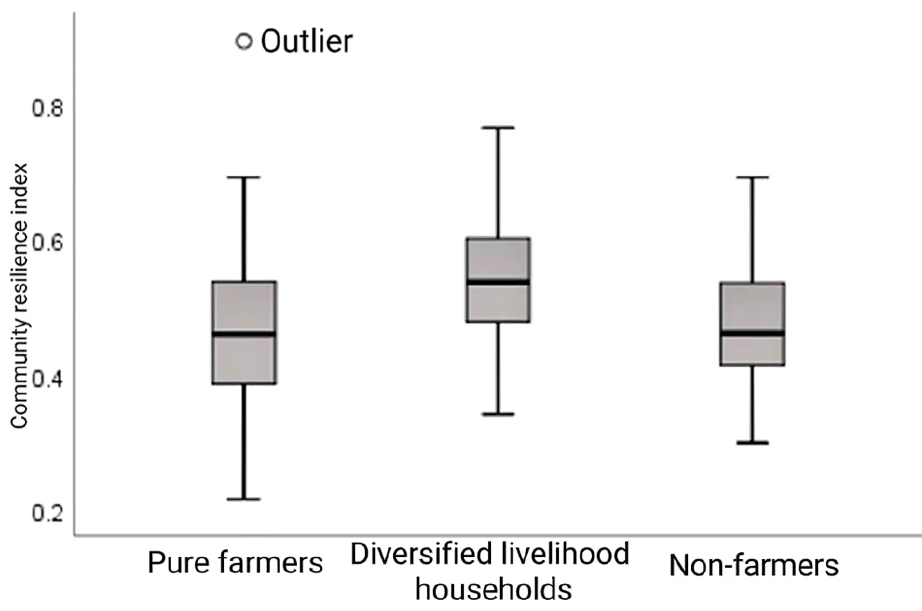
Figure 8. Community resilience index of relocated households in different livelihood types.